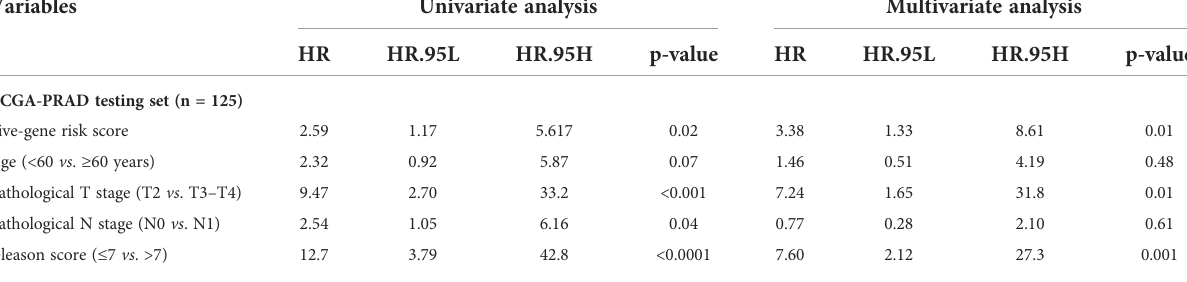
TABLE 4 Univariate and multivariate analyses of the fi ve-gene-based risk score and clinicopathological characteristics in TCGA-PRAD testing set (n = 125).